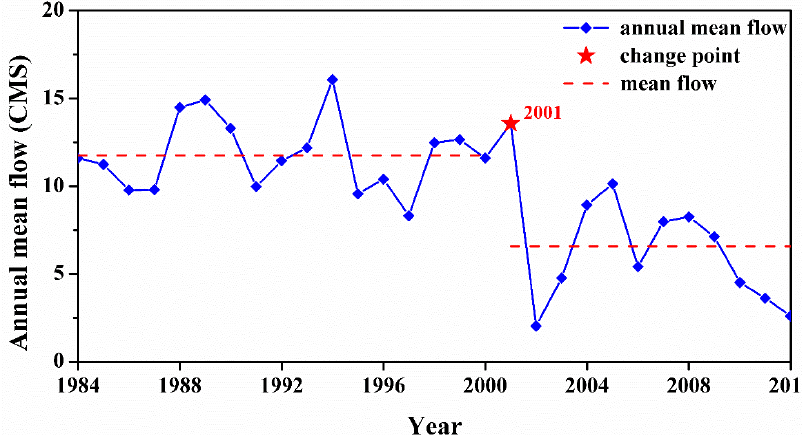
Figure 4. The results for the change points at the Ximen Bridge